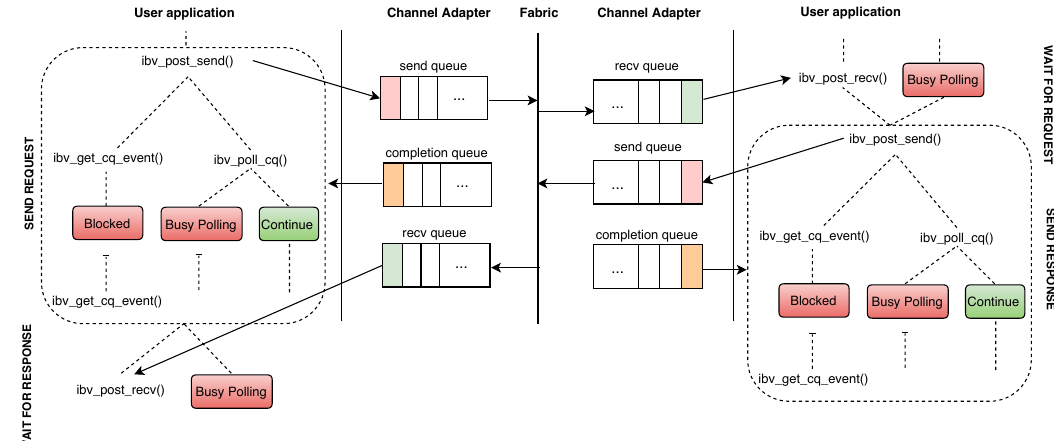
Figure 3. Synchronous and asynchronous RDMA